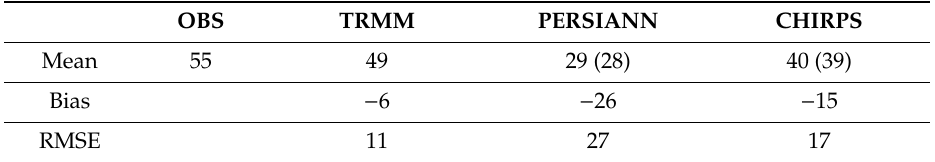
Table 1. Values of P99 (mm / day, computed from both wet and dry days) averaged from the 38 stations (OBS) and the nearest grid-point of three rainfall estimation products (TRMM, PERSIANN and CHIRPS), and corresponding skill scores (absolute bias and RMSE, in mm). For PERSIANN and CHIRPS, bracketed values indicate the mean for the period 1998–2014 instead of the full record. OBS TRMM PERSIANN CHIRPS Mean 55 49 29 (28) 40 (39) Bias − 6 − 26 − 15 RMSE 11 27